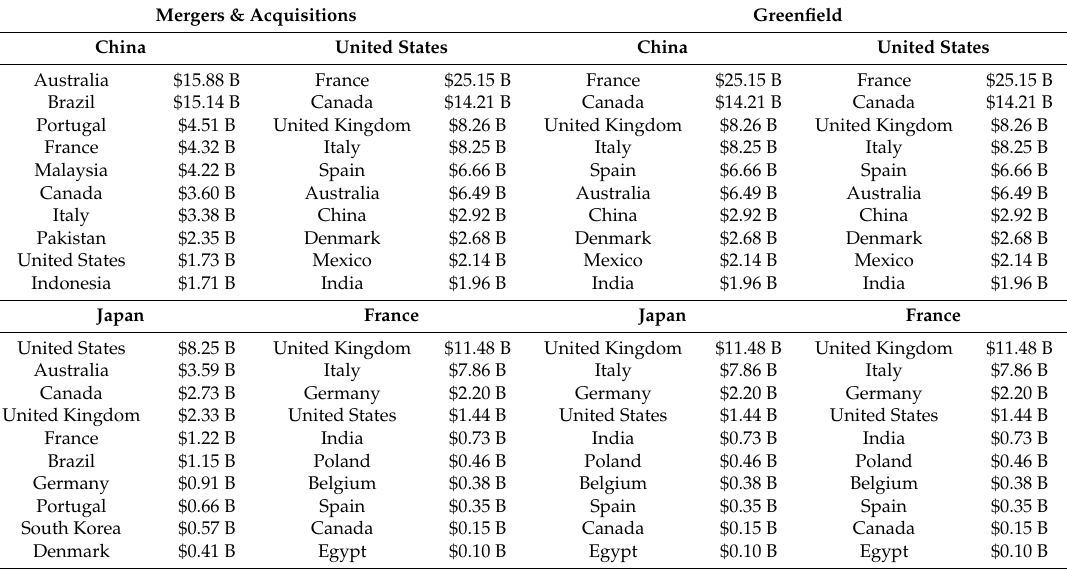
Table 5. Outbound FDI of China, USA, Japan, and France in the energy sector. Mergers &